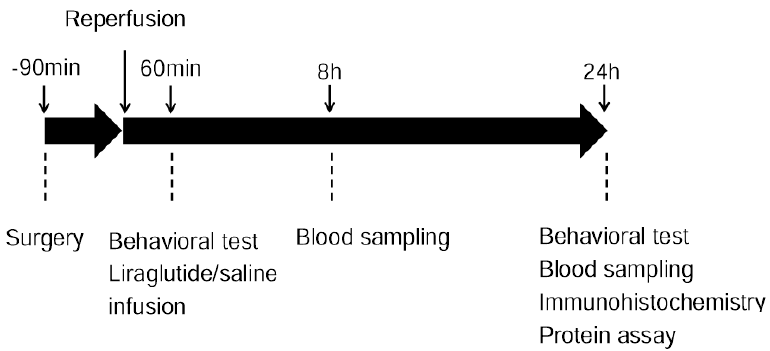
Figure 6. Experimental design. Rats in control and liraglutide-treated groups underwent MCAO surgery with subsequent reperfusion at 90 min after the occlusion. Behavioral test was performed at 1 and 24 h after reperfusion. Blood was sampled from caudal vein